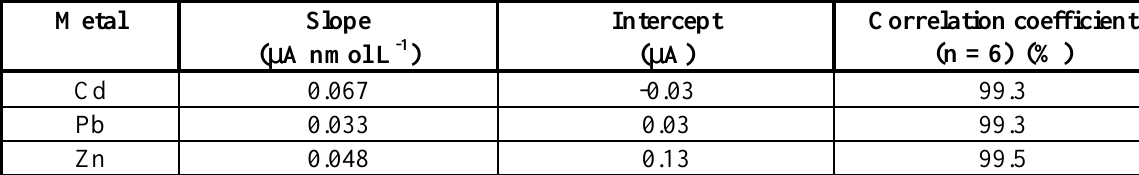
Table 2. Determination of zinc, lead and cadmium ions by SWASV at the poly(2 ABS). Metal Slope